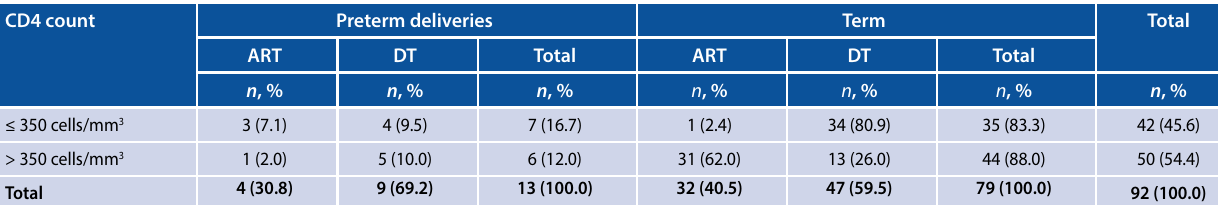
Note: ART: antiretroviral therapy, CD4: cluster of differentiation 4, DT: dual therapy